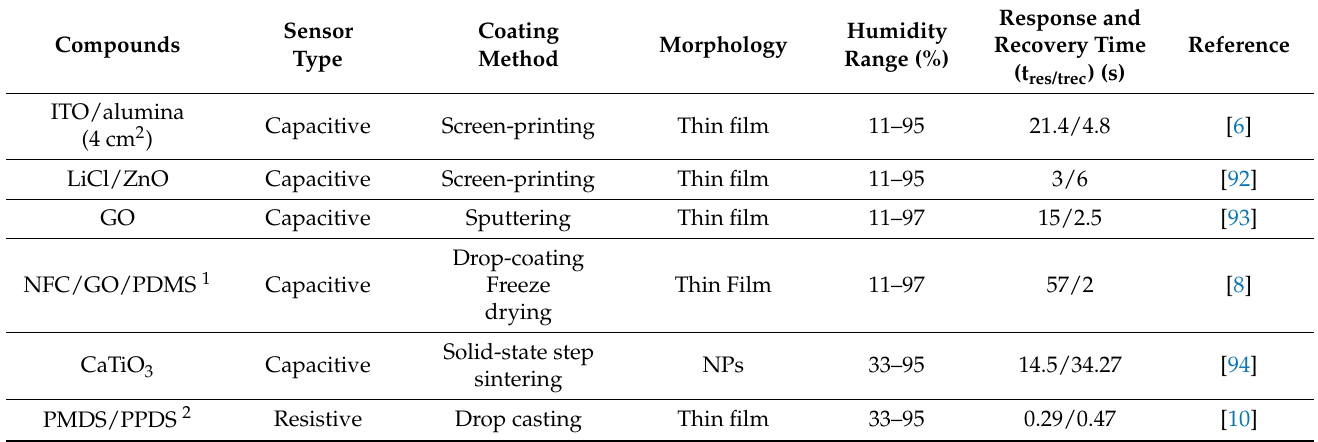
Table 2. Metal oxides, organic polymers, oxygenated salt, and halide perovskite among which are used as sensing materials in resistive and capacitive humidity